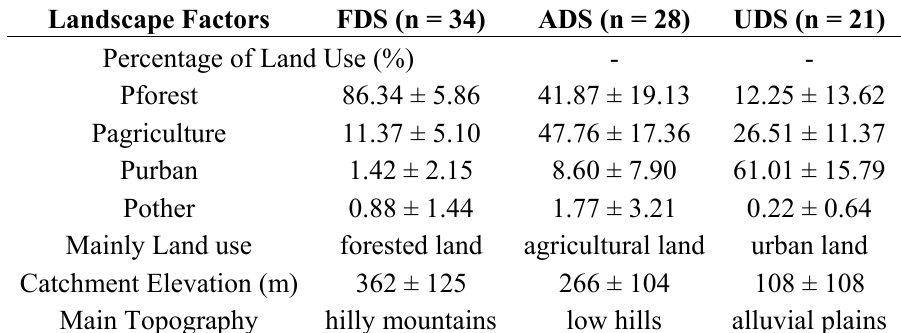
Figure 2. Dendrogram based on the hierarchical clustering analysis according to the Ward linkage method using Euclidean distance, showing the different clusters from the 83 sampling sites (S01–S83). Table 2. General characteristics for the site groups (mean value ± standard